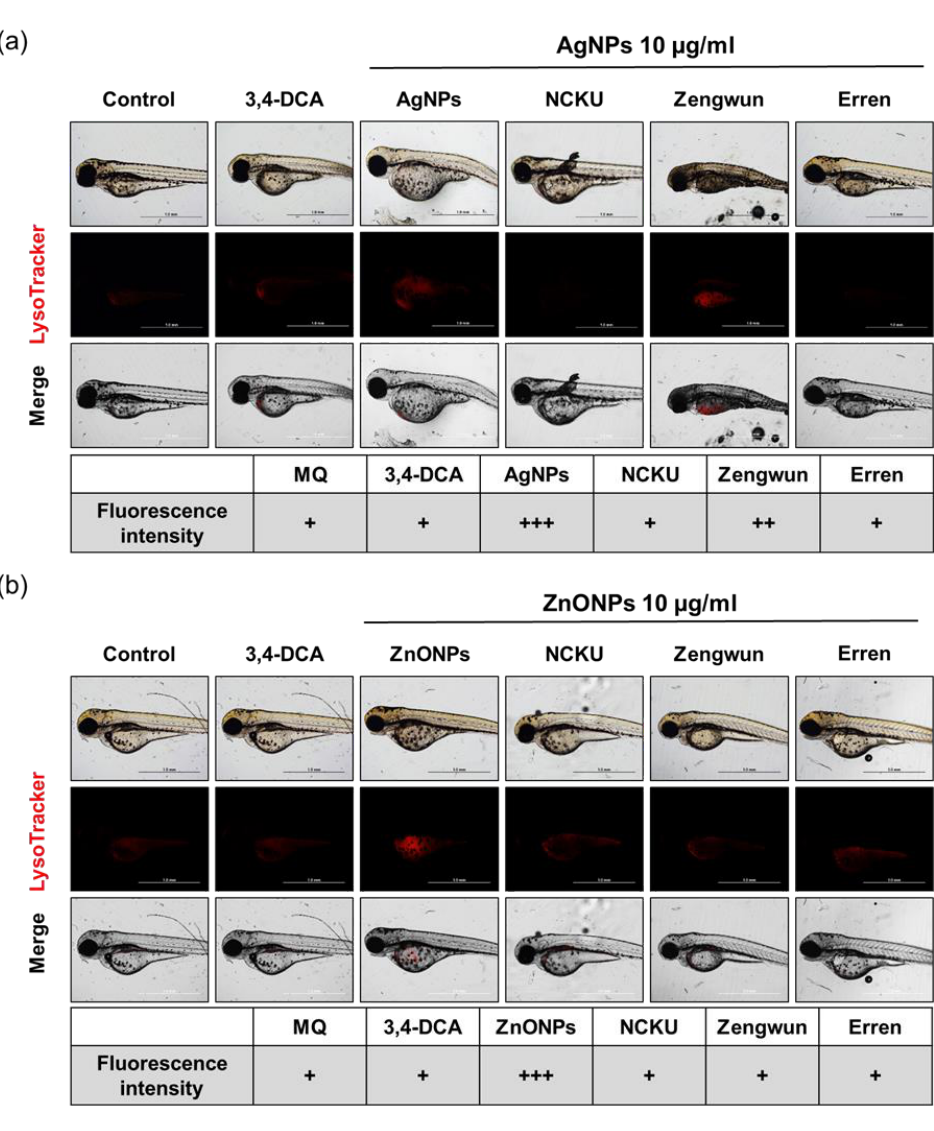
Figure 8. Autophagy induced by AgNPs and ZnONPs. Zebrafish embryos were exposed to natural water after passing through a 0.45 µm filter and then spiked with ( a ) AgNPs and ( b ) ZnONPs. After 72 hpf, zebrafish embryos were stained with LysoTracker RED. The fluorescence intensity was assigned as + (weak), ++ (middle), and +++ (strong). The 10 µ g/mL MQ groups exhibited higher autophagy signals than groups treated with NPs spiked in natural water samples. AgNPs, silver nanoparticles; ZnONPs, zinc oxide nanoparticles; 3,4-DCA, 3,4-dichloroaniline; hpf, hours